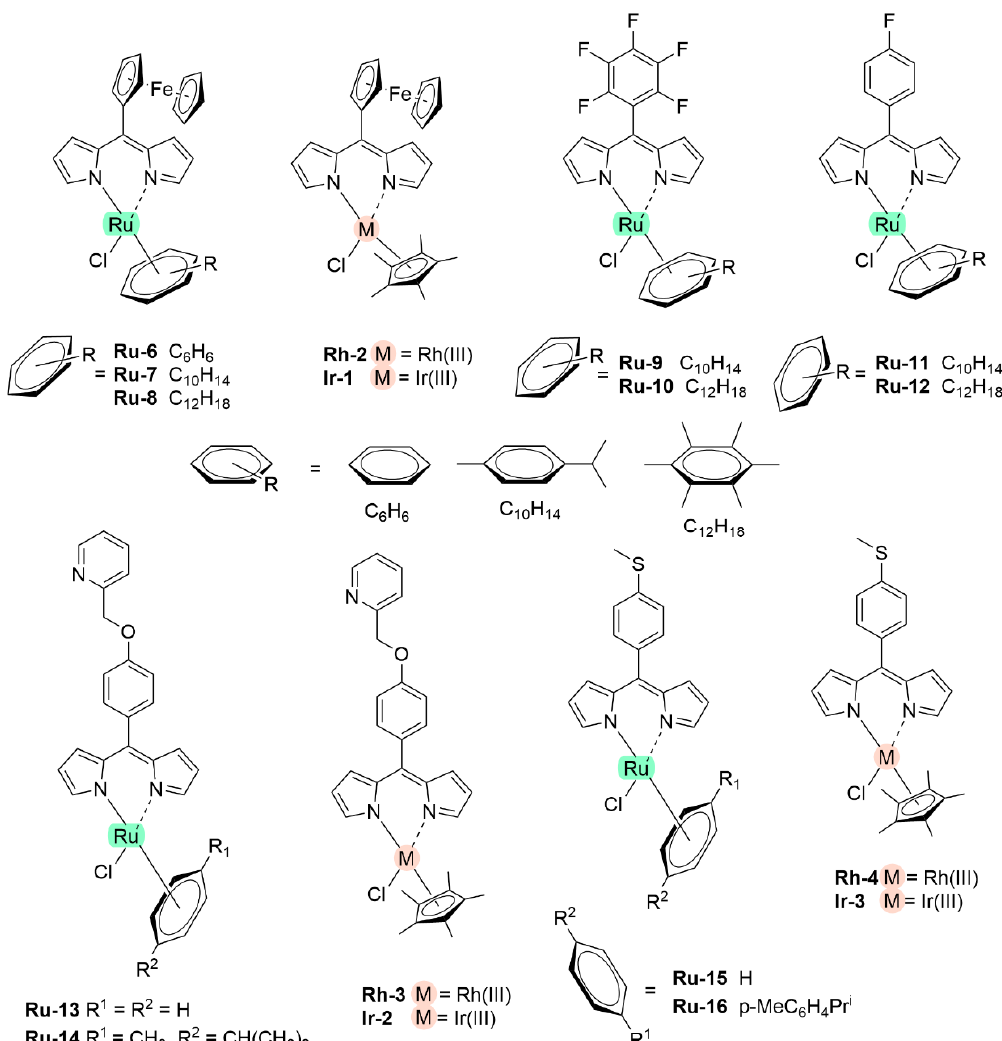
Figure 14. Chemical structures of heteroleptic Ru(II), Rh(III) and Ir(III) dipyrrinato complexes.